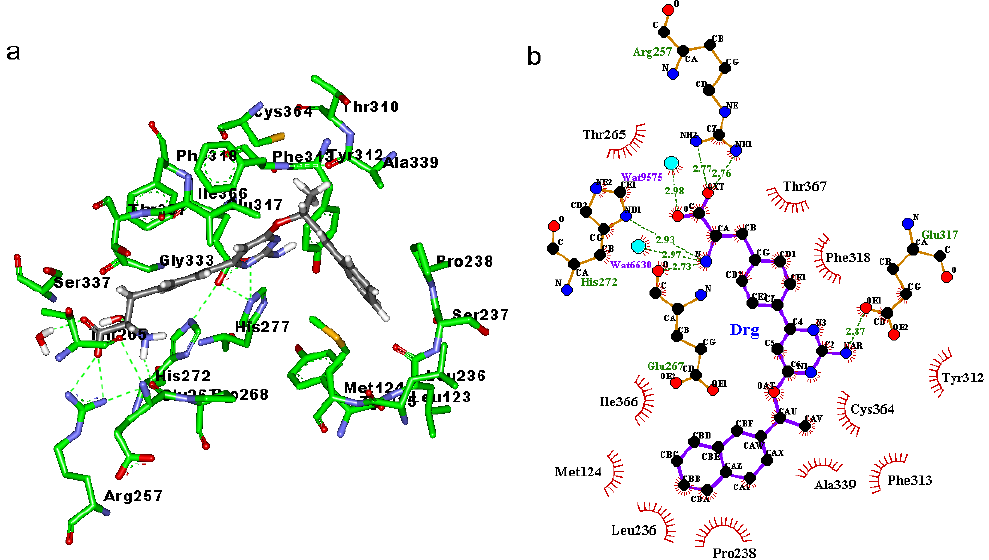
Figure 5. ( a ) Binding modes of inhibitor 1b with the key residues of TPH1 that are essential for the binding; ( b ) 2D contour of the binding modes generated by Ligplot plus.